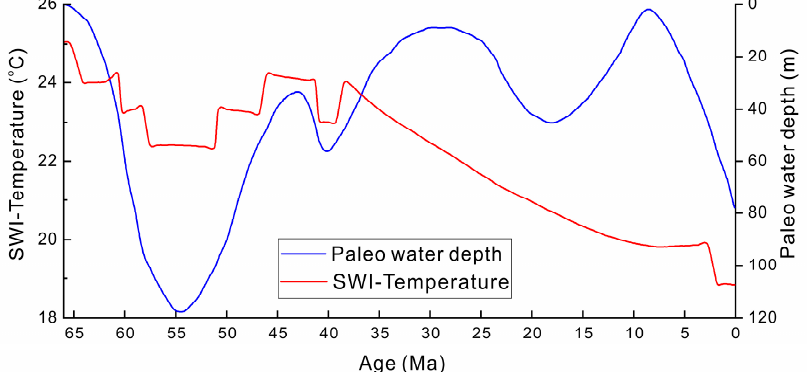
Figure 11. The paleo water depth and sediment water interface temperature (SWI-Temperature) curves through geologic time. through geologic